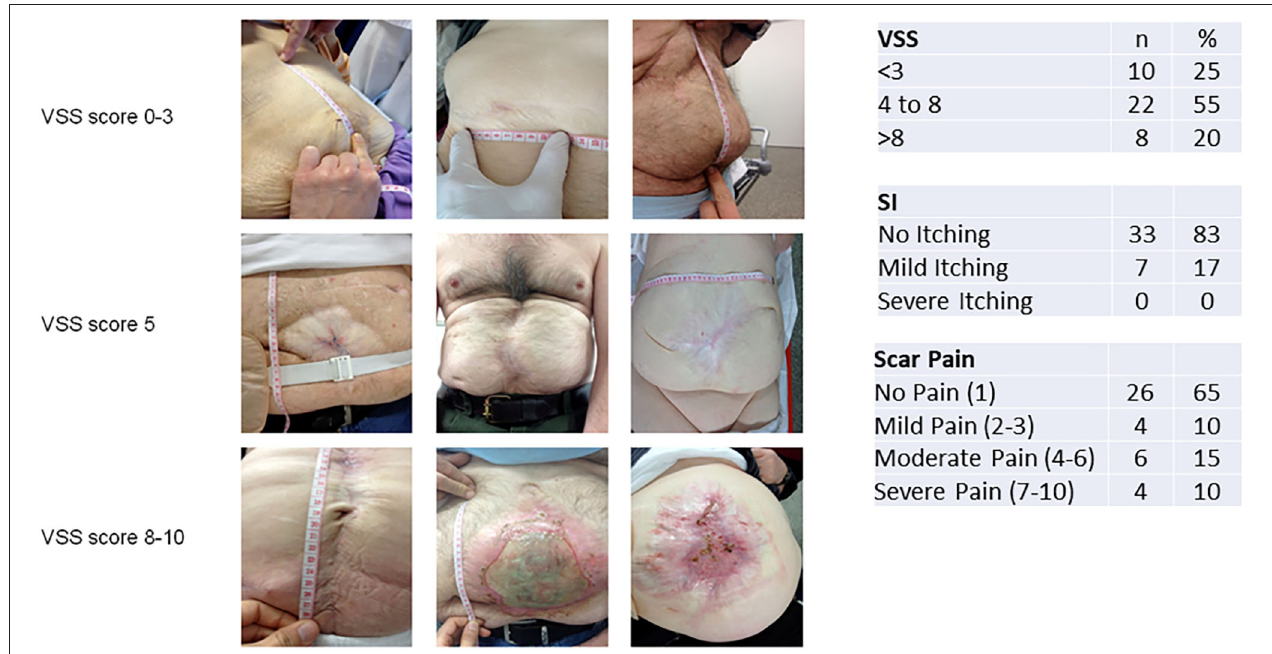
FIGURE 3 | Vancouver Scar Scale (VSS) assessment combined with scar itching and pain scores. Shown are the VSS assessment scale and scar itching and scar pain results with clinical examples from our cohort.